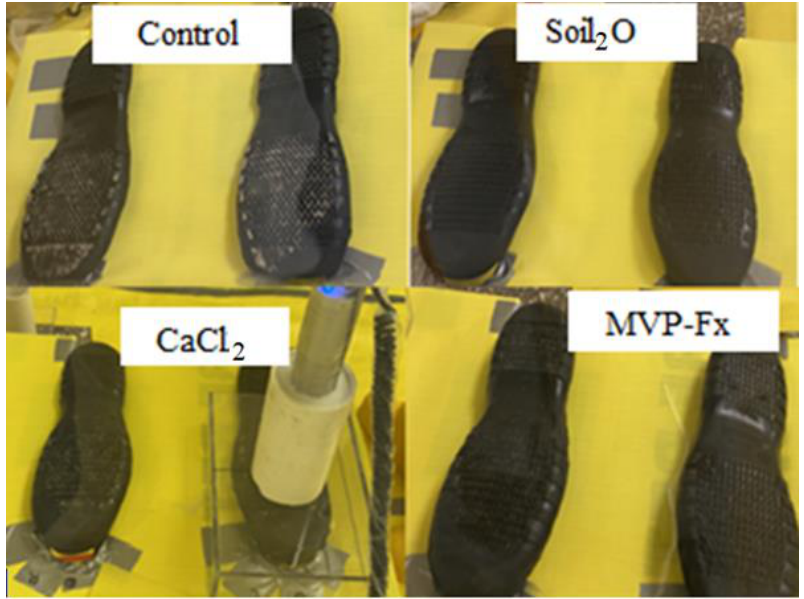
Figure 9. Customized stand for activity measurements from boots, shown for CaCl 2 . Also visible is residue on boots from contaminated asphalt without stabilization technology, indicated as the control, and with the labeled stabilization technologies. The use of the radiation detector is depicted for the CaCl 2 stabilizer; its use was similar for the other stabilizers and the nonstabilized control.